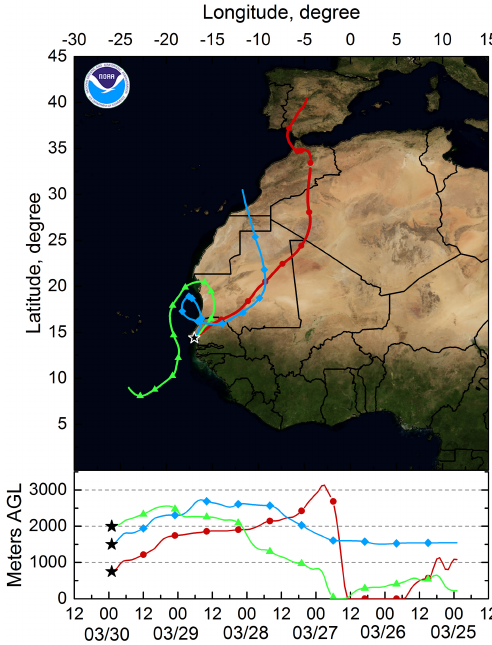
Figure 11. Five-day backward trajectories for the air mass in Mbour at altitudes of 750, 1500, and 2000m on 29 March 2015 at 23:00UTC.